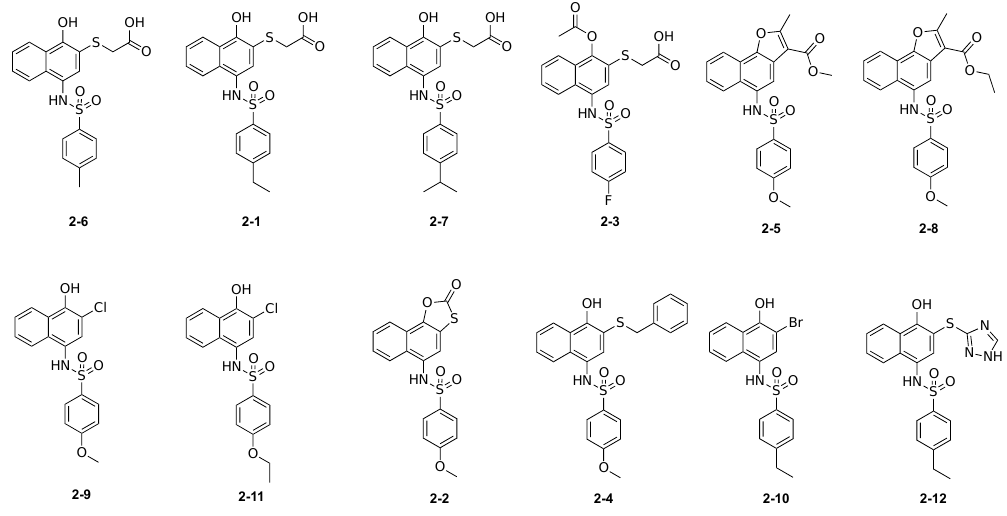
Figure 4. Structures of 12 compounds resulting from a similarity search based for C10 .